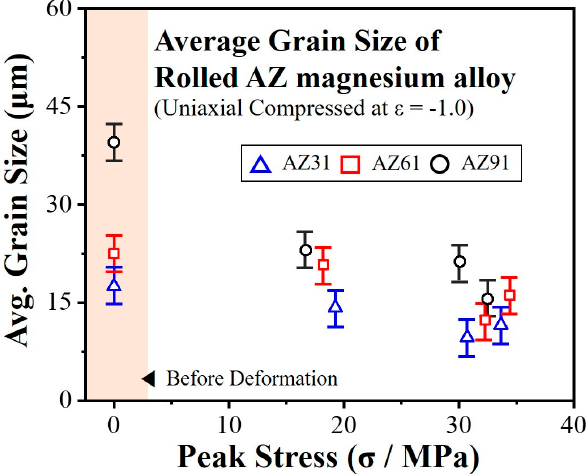
Figure 5. Relationship between the grain size after uniaxial compression and the peak stress.